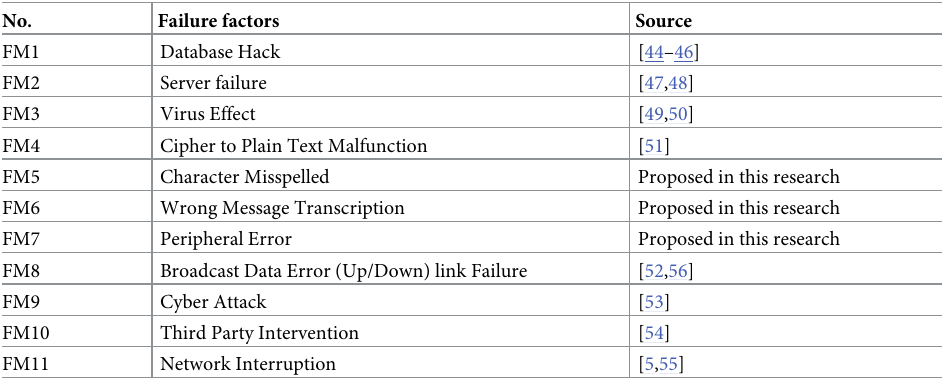
Table 1. Failure factors of IT System in the Banking